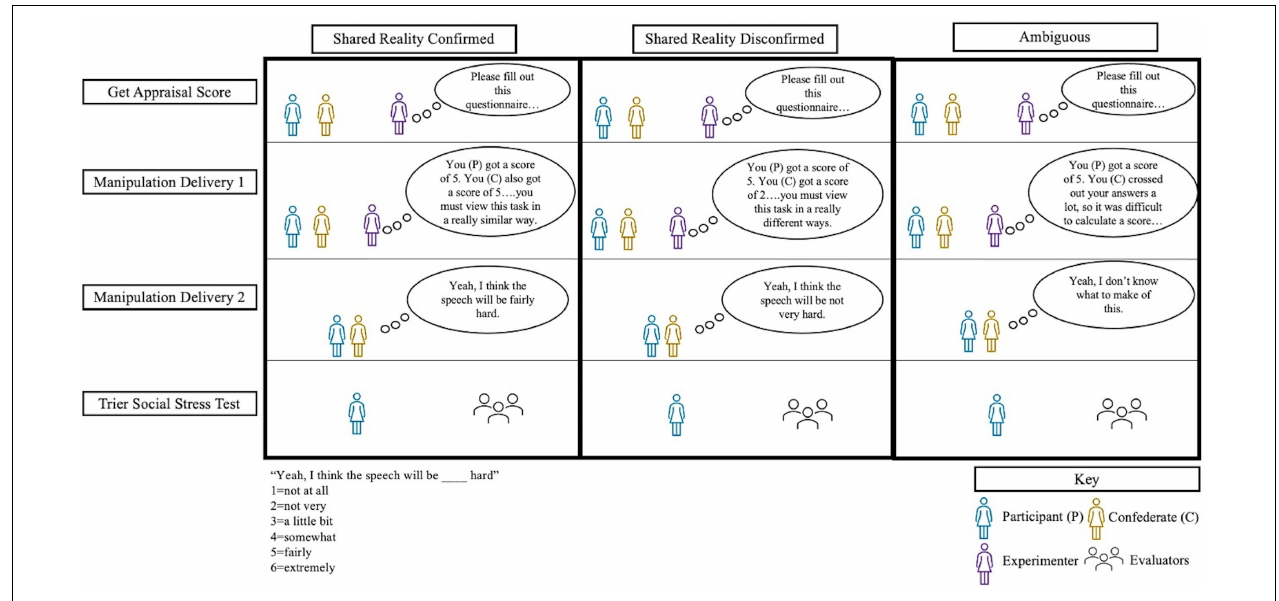
FIGURE 1 | Schematic of study